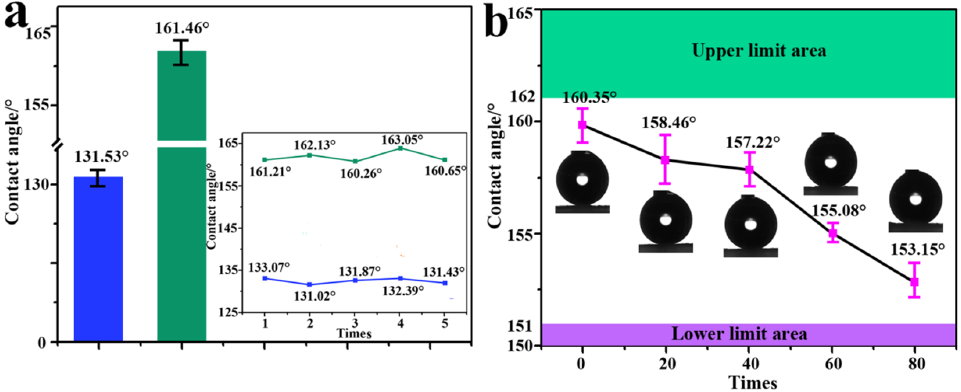
Figure 8. ( a ) Comparison diagram of contact angle between original paper mulching film and coated paper mulching film, ( b ) Contact angle diagram corresponding to mechanical bending cycle times.